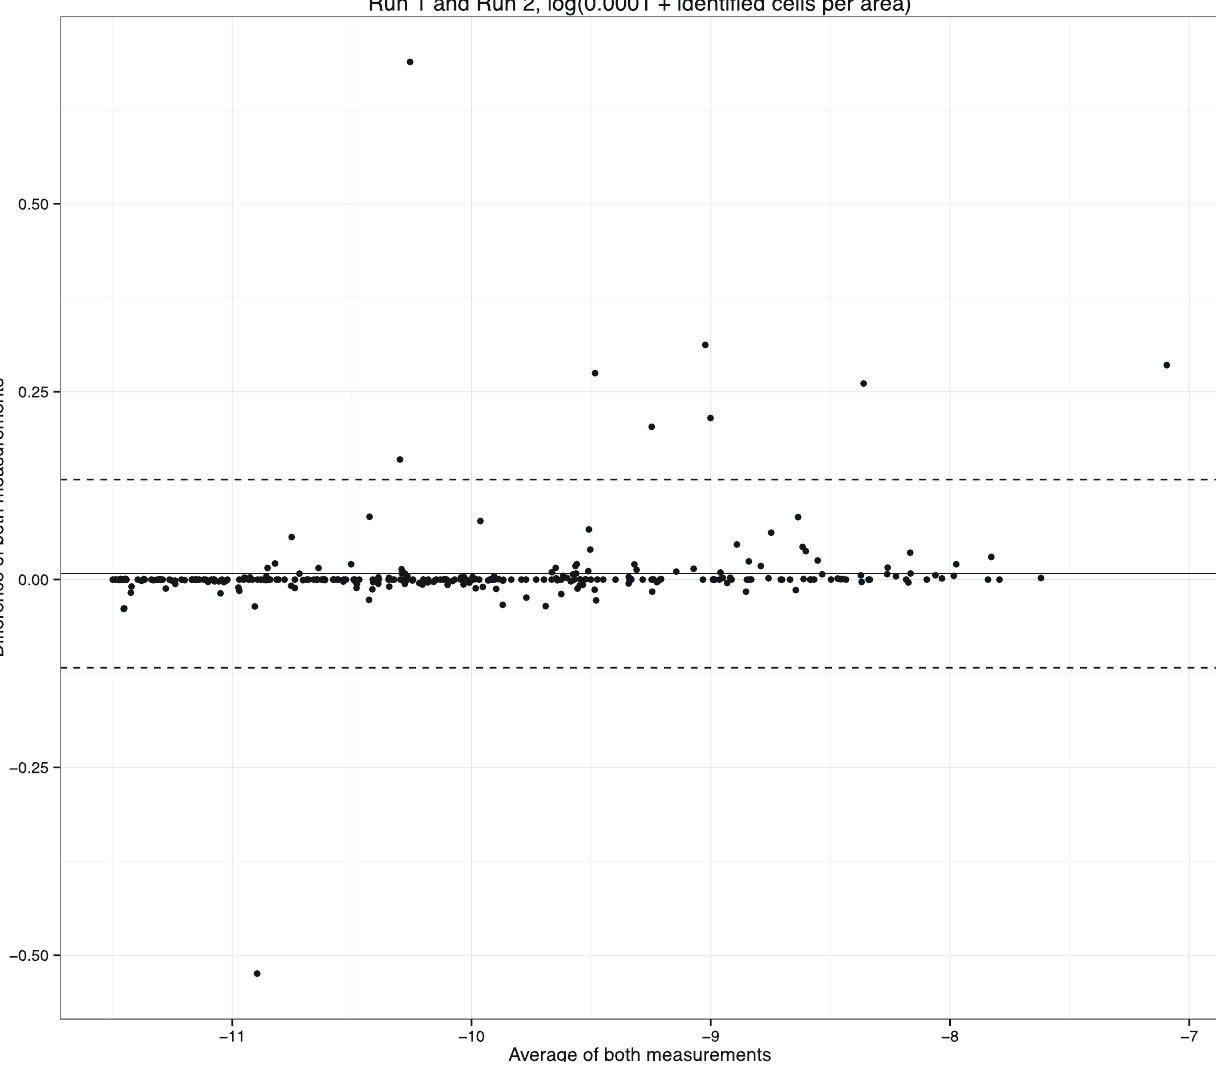
Figure 4. Bland and Altman plot of both measurements of number identified cells per area (Run1 and Run2). Measurements were log transformed, log(0.0001 + identified cells per area). The intraclass correlation coefficient (ICC) using two-way mixed single measures was 0.99.